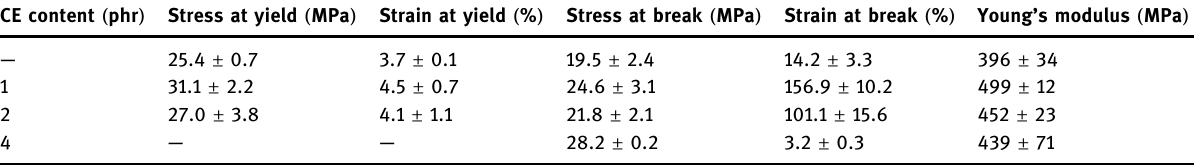
Table 4: Tensile properties of in situ chain - extended PLLA - PEG - PLLA fi lms CE content ( phr ) Stress at yield ( MPa ) Strain at yield ( % ) Stress at break ( MPa ) Strain at break ( % ) Young ’ s modulus ( MPa